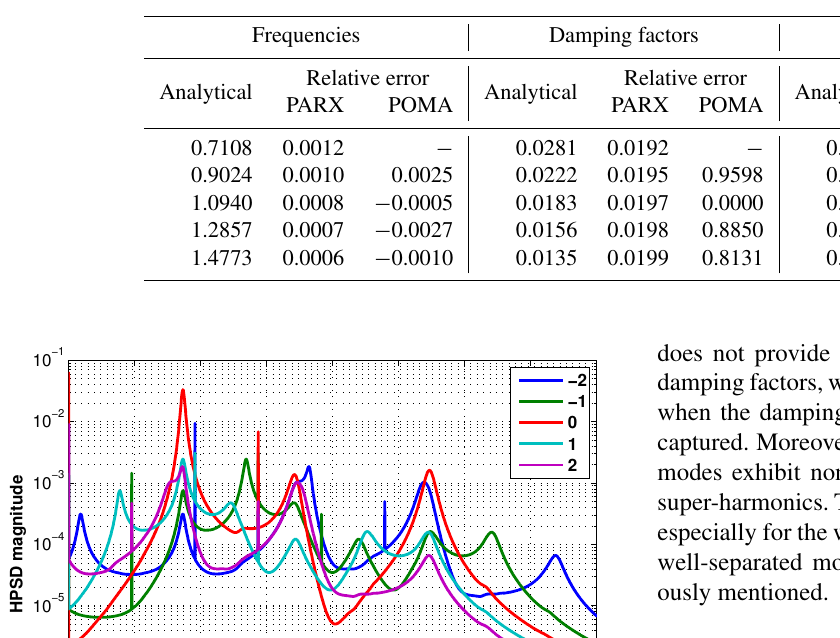
Table 7. Analytical results and estimation errors of in-plane forward whirling modal parameters.